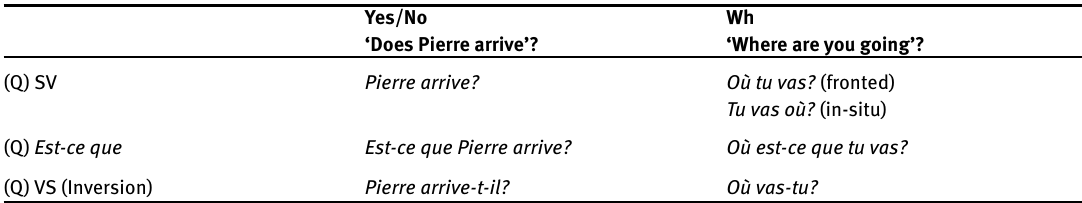
Table 1. Types of interrogative formation in